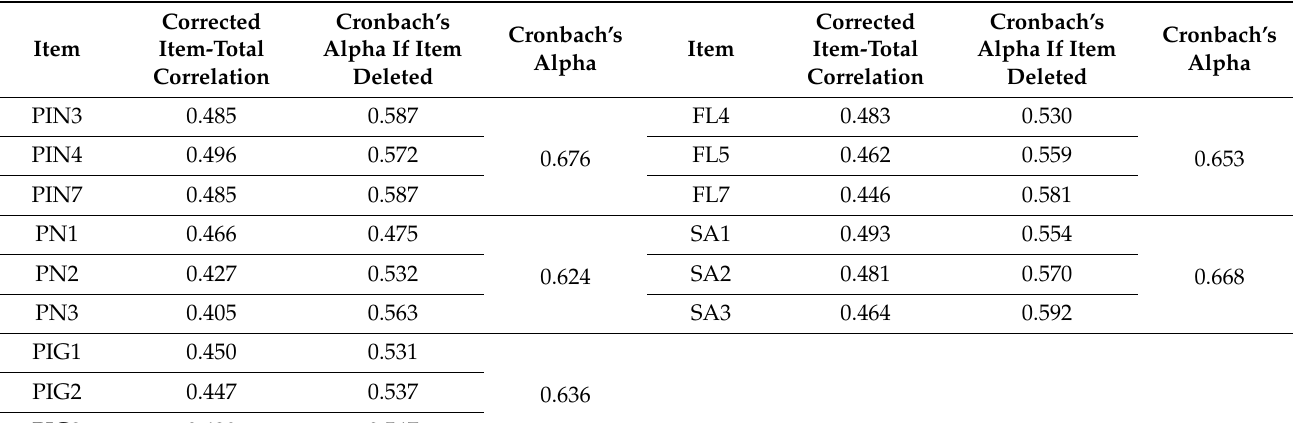
Table 5. Reliability analysis results.